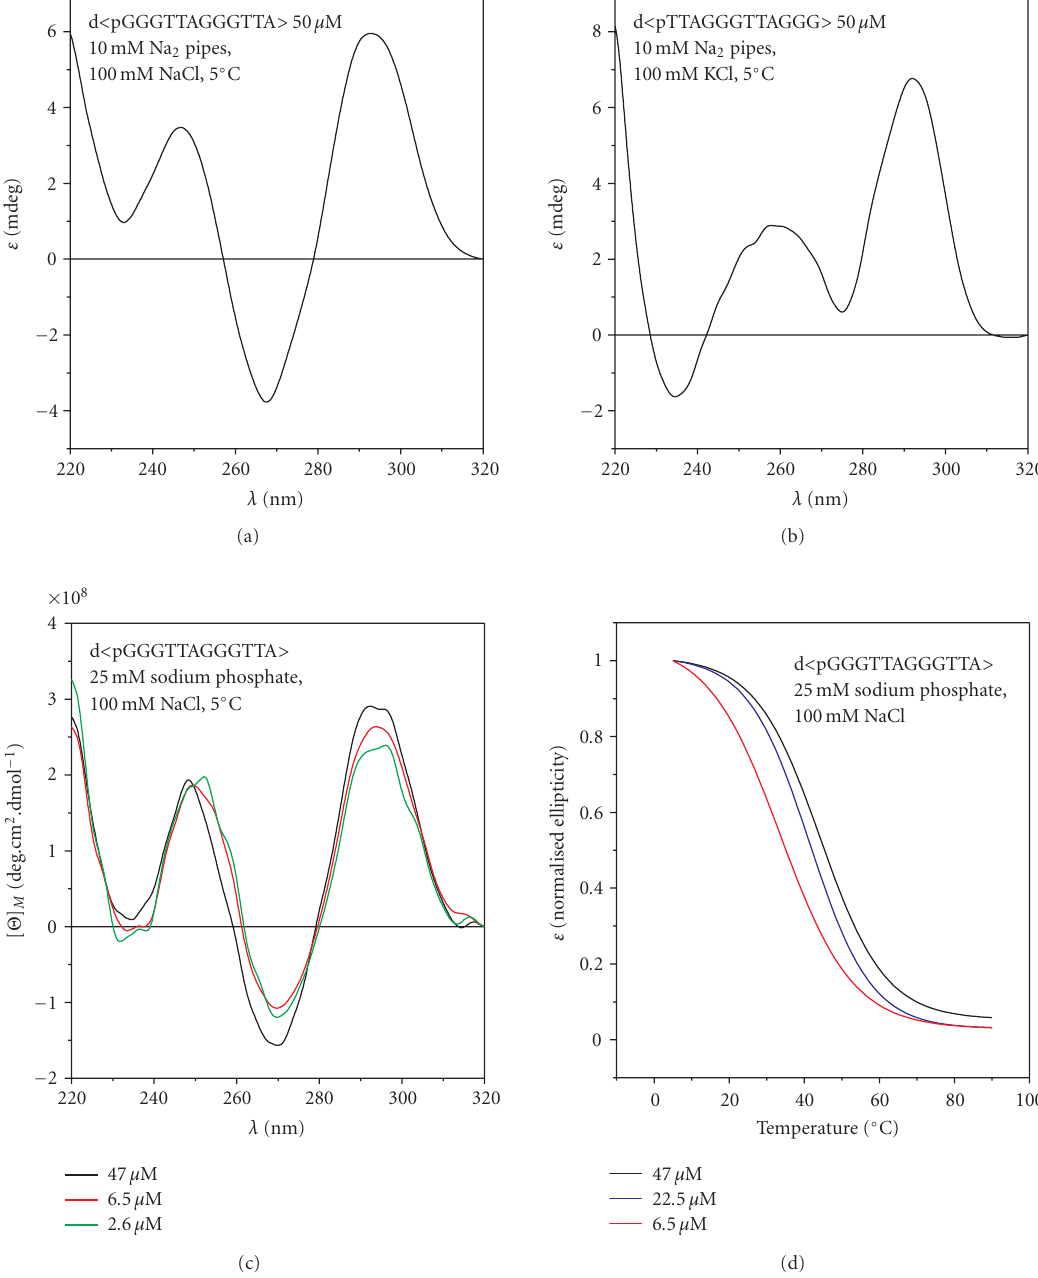
Figure 5: CD spectra of d < pGGGTTAGGGTTA > in media containing Na + (a) or K + (b). Converted to molar ellipticity CD spectra (c) and normalized melting curves (d) at di ff erent oligonucleotide concentrations in the same bu ff er conditions as NMR experiments.